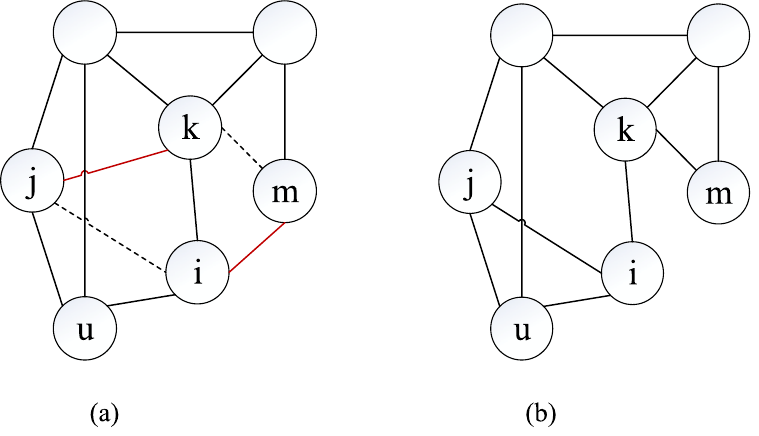
Figure 8. Structure adjusted before and after edge switching. ( a ) Initial structure G i . ( b ) Structure adjusted ( G i ’). Remove e jk and e im from structure G i in ( a ); then, e ji and e km are added, thereby gaining a new structure G i ’ in ( b